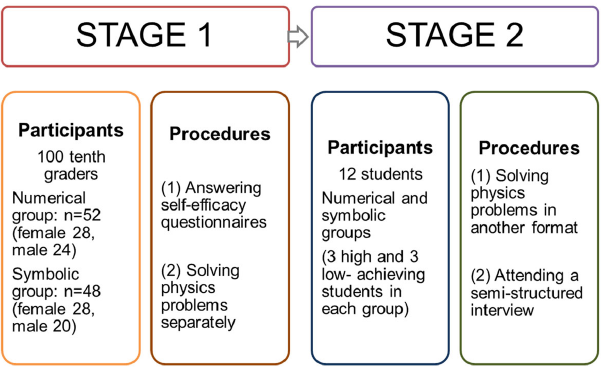
FIG. 2. Procedures and participants in the